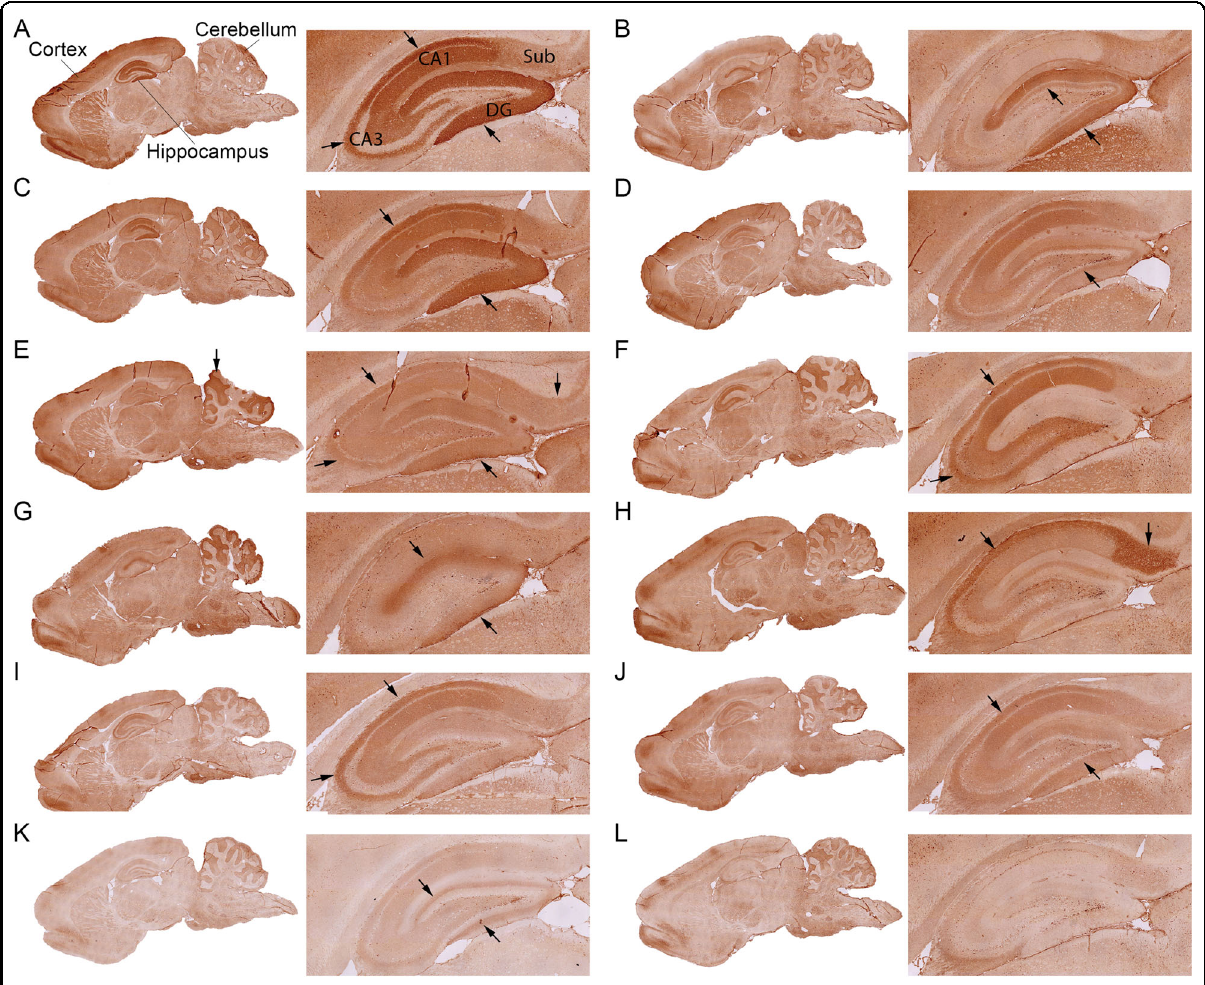
Fig. 1 Novel rat brain immunohistochemistry patterns of autoantibodies from NESDA cohort individuals. A – K represent 11 unique IHC staining patterns of plasma autoantibodies on sagittal sections of rat brain. For each pattern, also a larger magni fi cation of the hippocampus is shown. Arrows indicate regions with the strongest immunoreactivity in the hippocampus or cerebellum. The CA1, CA3, dentate gyrus (DG), and subiculum (Sub) regions of the hippocampus are labeled in A. l represents a negative staining result from a healthy individual. Scale bar = 500